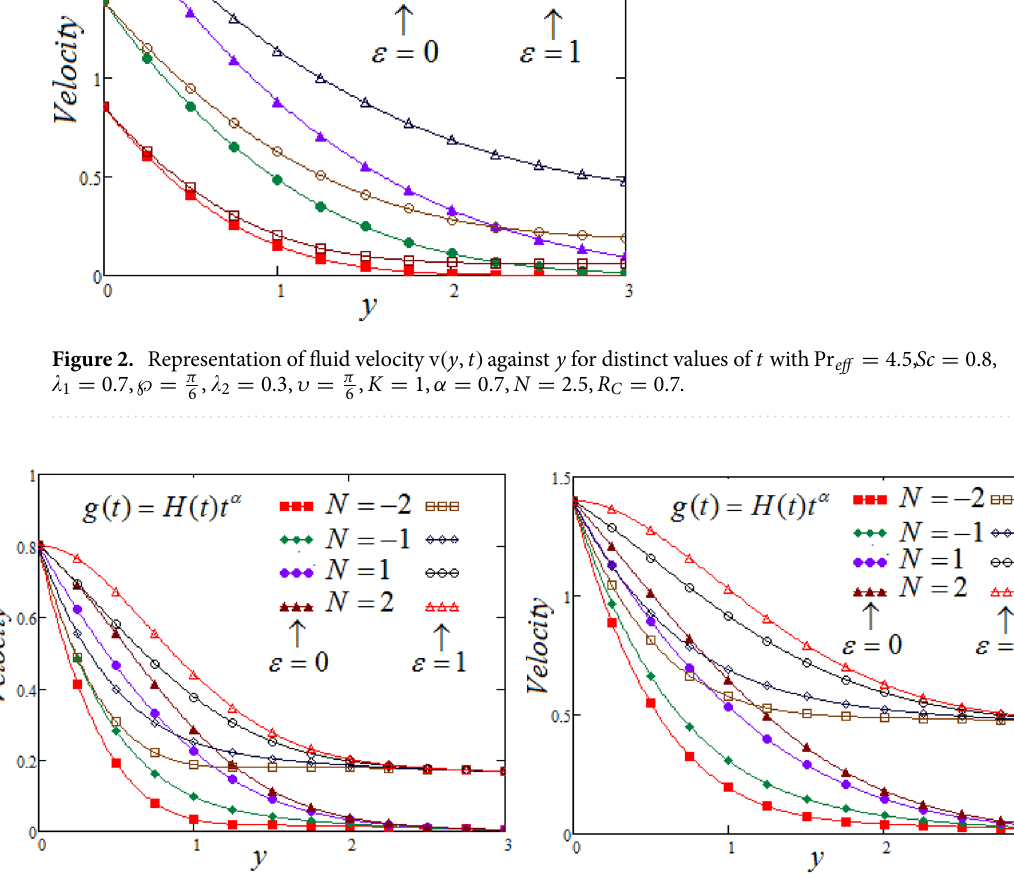
Figure 3. Representation of fluid velocity v ( y , t ) against y for distinct values of N with Pr eff = 4.5, Sc = 0.8, (cid:31)